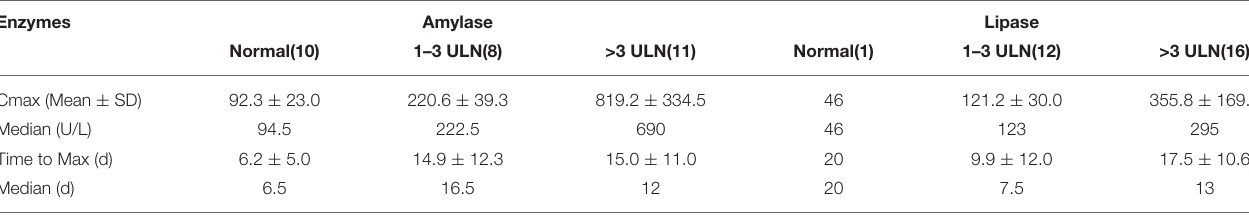
TABLE 5 | Elevated amylase or lipase of 29 patients with COVID-19. Enzymes